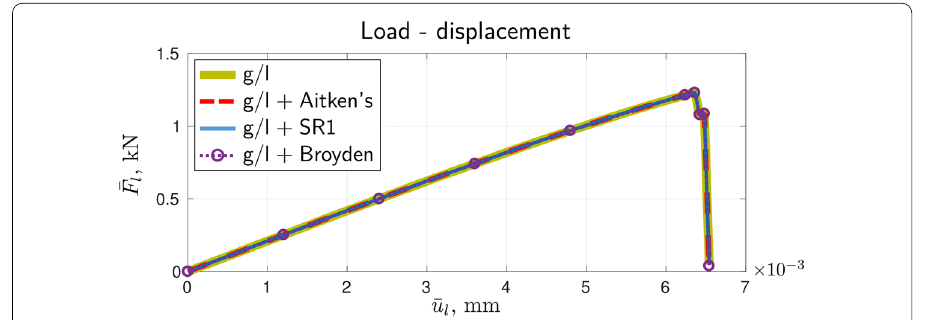
Fig. 12 Comparison of the load-displacement curves